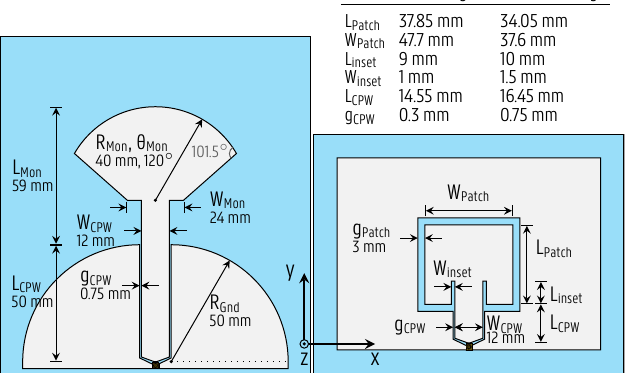
Figure 4. To-scale representation of the printed antennas. Left: Monopole covering the [862–928]MHz Sigfox band; right: coplanar patch covering the [2.4–2.5]GHz WiFi band. The table lists the values for the defined parameters, which were modified during the coplanar patch antenna redesign, whereas the other parameter values are indicated below their